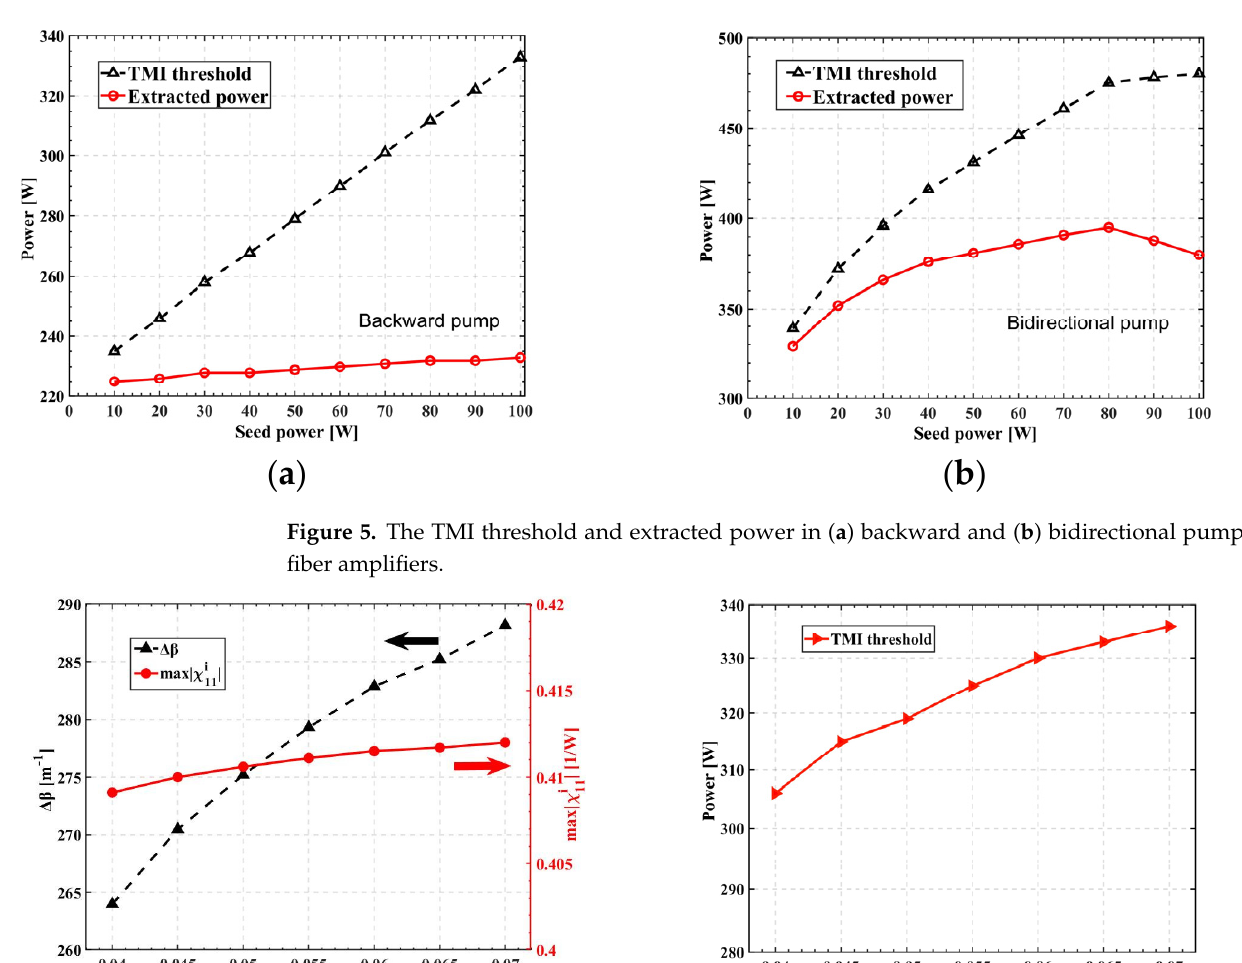
Figure 5. The TMI threshold and extracted power in ( a ) backward and ( b ) bidirectional pumped fiber amplifiers.